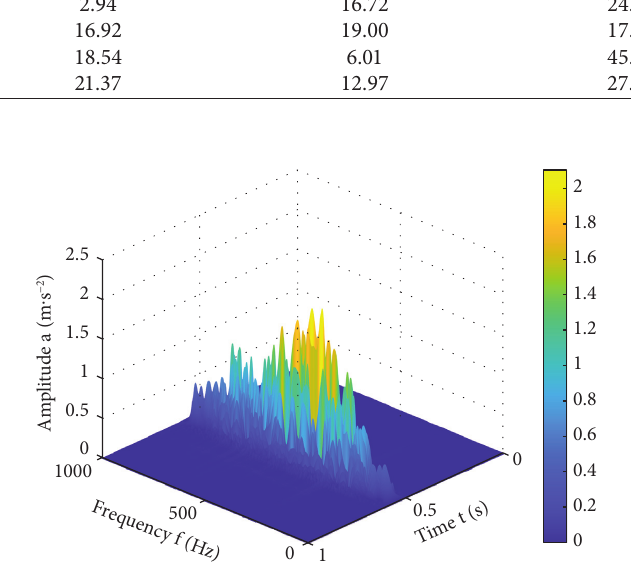
Figure 8: Three-dimensional spectrum of BIMF.